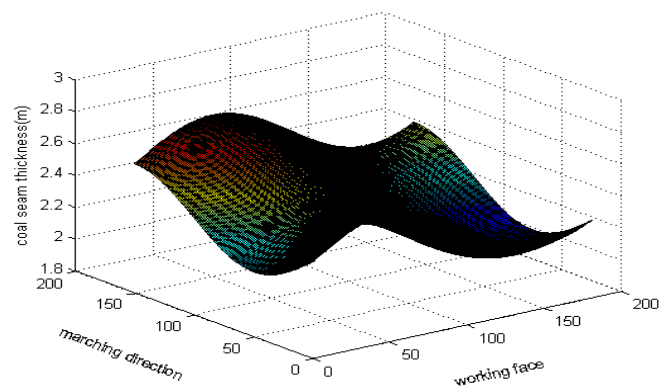
Figure 8. Simulated coal seam surface.